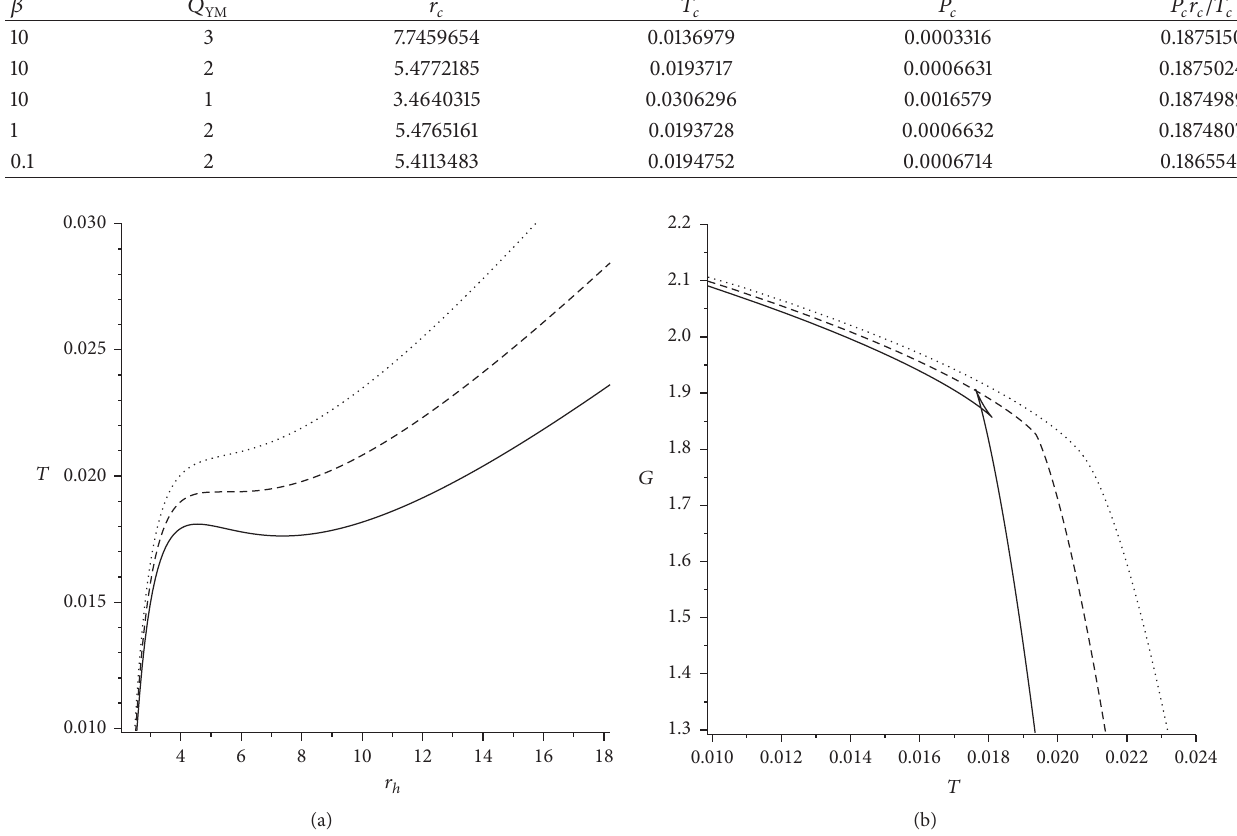
= 2 , 𝑄 = 1 , and 𝛽 = 10 . The isobars on 𝑇 - 𝑟 Figure 2: Isobaric plots for 𝑄 𝑒 YM other. On both (a) and (b), from top to bottom, the pressures are, respectively, 𝑃 = 1.2𝑃 𝑐 (dotted), 𝑃 = 𝑃 𝑐 (dashed), and 𝑃 = 0.8𝑃 𝑐 (solid).